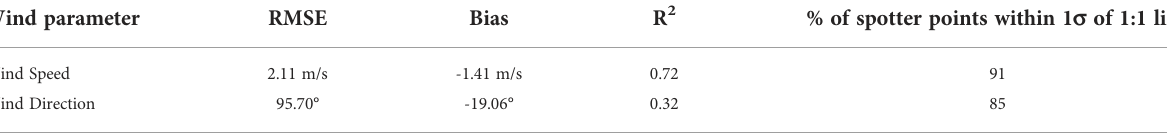
TABLE 3 Statistics comparing wind parameters recorded by the Meteorological buoy and Spotter wave